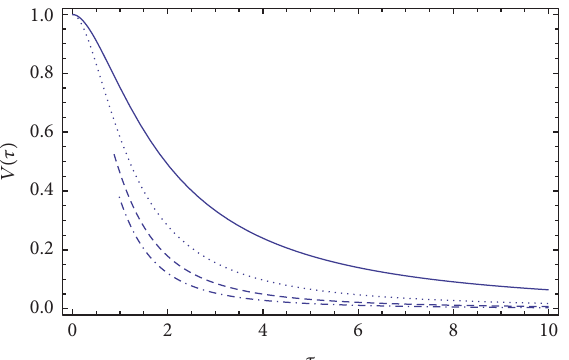
Figure 3: Variation of the scalar field potential 𝑉 = exp (−𝜆𝜙) as a function of the dimensionless time 𝜏 for different values of the parameter 𝜆 : 𝜆 = −1 (solid curve), 𝜆 = −√2 (dotted curve), 𝜆 = −√3 (dashed curve), and 𝜆 = −2 (dashed dotted curve).